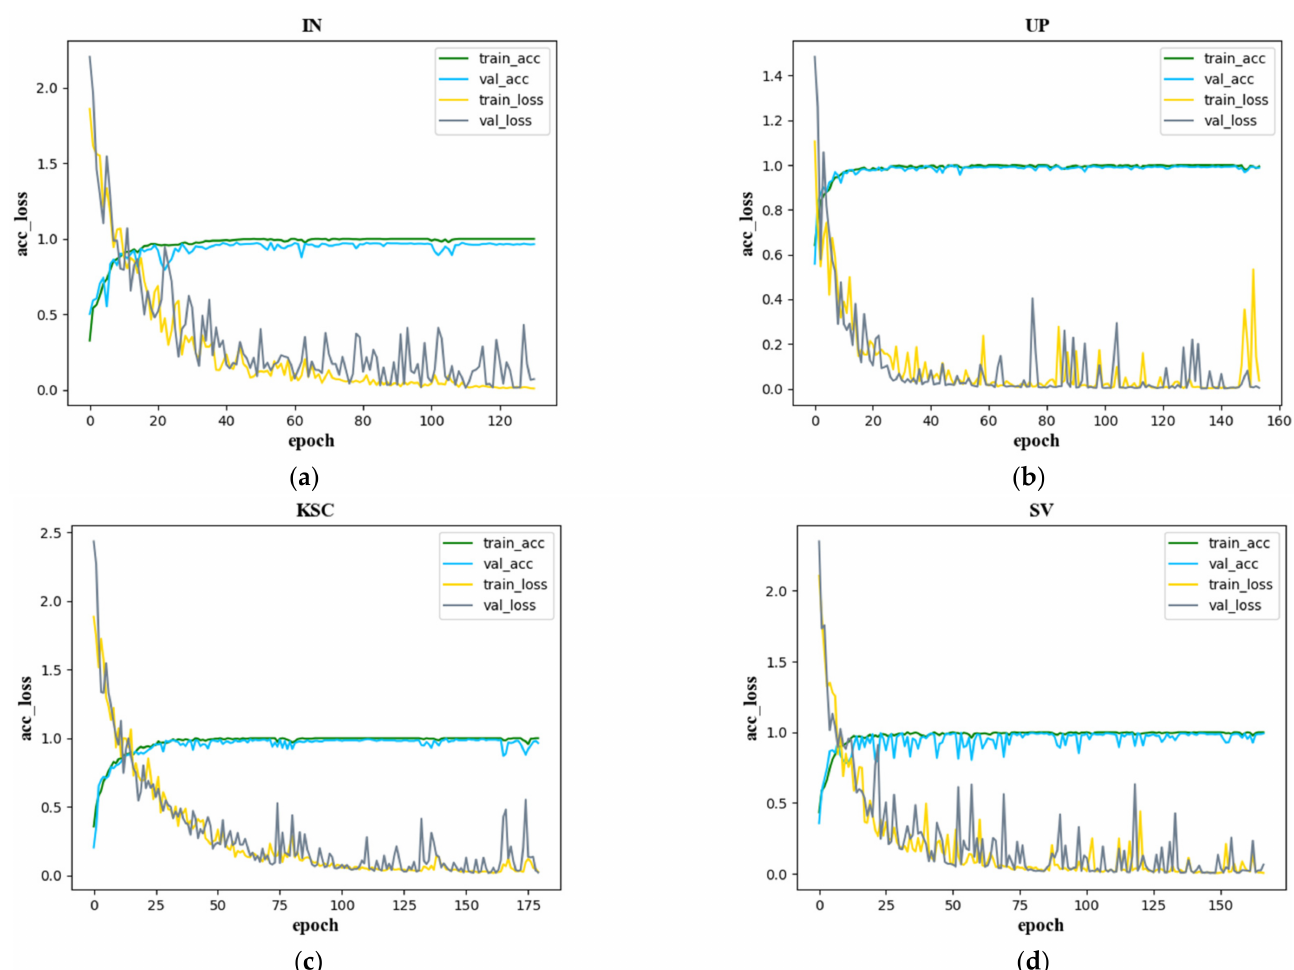
Figure 14. Accuracy and loss function curves of the training and validation sets for ( a ) IN, ( b ) UP, ( c ) KSC, and ( d ) SV.